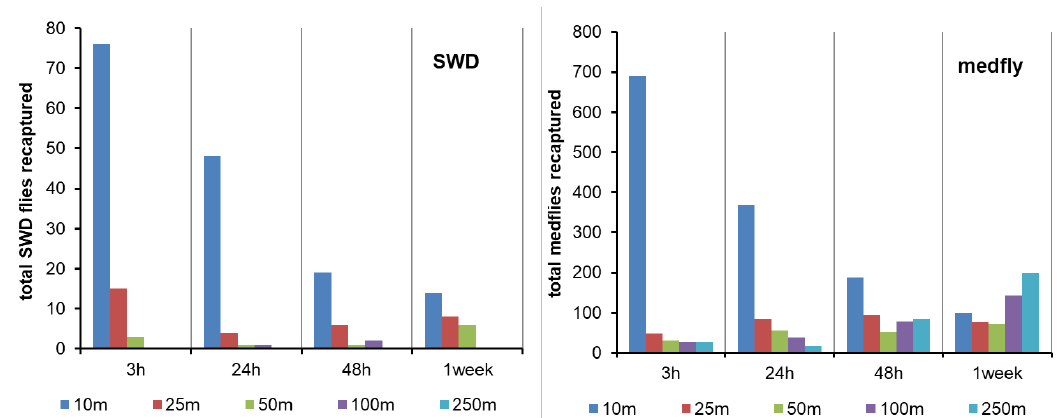
Figure 4. Total number of recaptured flies (left: D. suzukii (SWD); right: C. capitata (medfly)) in each sampling interval and at different distances from the release point during the three spring 2016 trials.